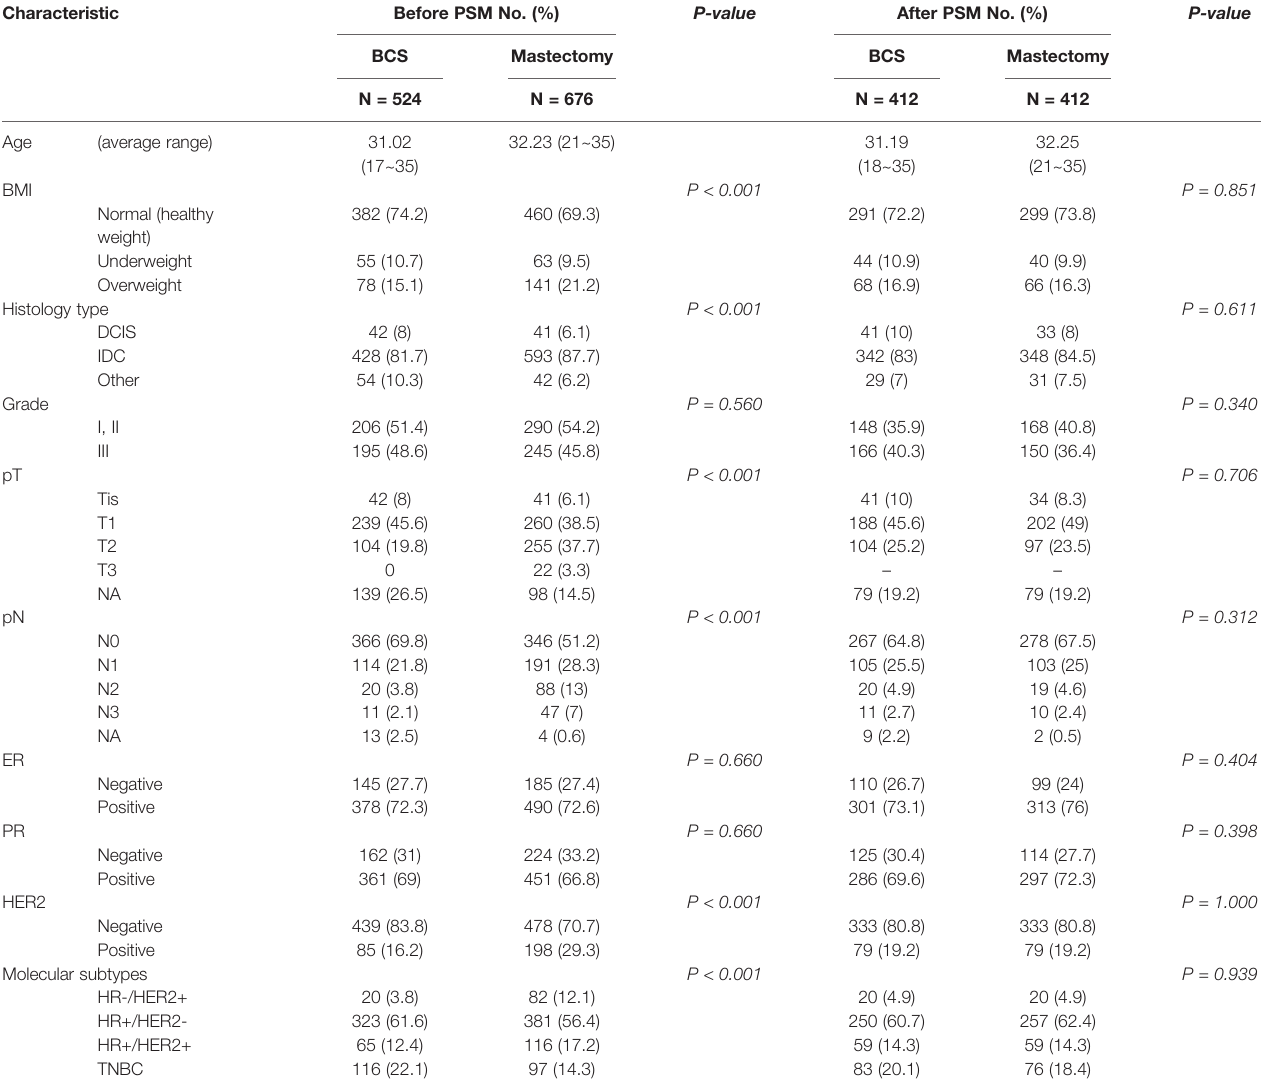
TABLE 2 | After propensity score matching, the baseline characteristics of breast-conserving surgery vs. mastectomy alone. Characteristic Before PSM No.